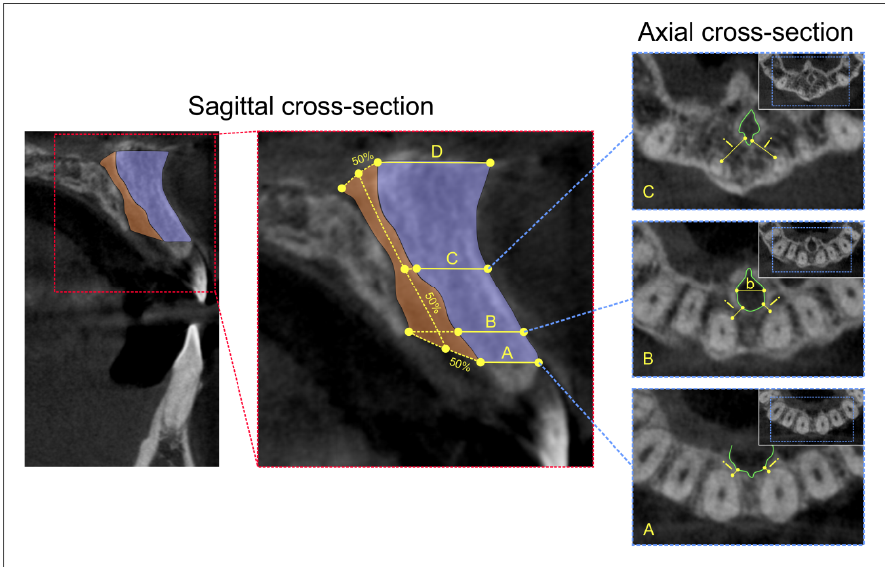
Figure 2. The definition of morphometric parameters of interest on CBCT images of the anterior maxilla. Sagittal cross-section; sagittal CBCT view with the marked field of interest ( left ); selected morphometric parameters for analyses ( right ): ( A ) the distance between the cortical layer of the incisive foramen and facial aspect of the buccal bone plate; ( B ) the distance between the cortical layer of the nasopalatine canal and facial aspect of the buccal bone plate using a horizontal line from the palatal border of the incisive foramen; ( C ) the distance between the cortical layer at the midpoint level of NPC length and facial aspect of the buccal bone plate; and ( D ) the distance between the cortical layer of the nasal foramen and facial aspect of the buccal bone plate. Axial cross-section; axial CBCT view: ( bottom ) the minimal interspace (i) between incisive foramen and central incisors at level A; ( middle ) the minimal interspace (i) between incisive foramen and central incisors at level B; (b) M-L diameter of incisive foramen; and ( upper ) the minimal interspace (i) between NPC and central incisors at level C.